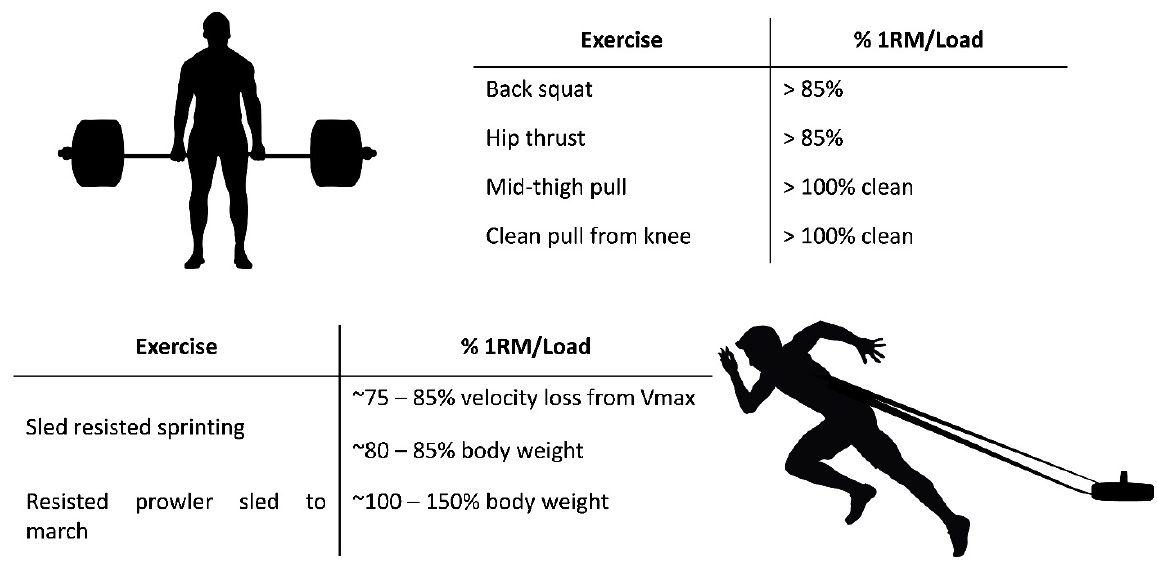
Figure 2. Suggested exercises to improve force production and mechanical effectiveness, adapted from Hicks et al. [24], Morin et al. [25] and Lahti et al. [26].